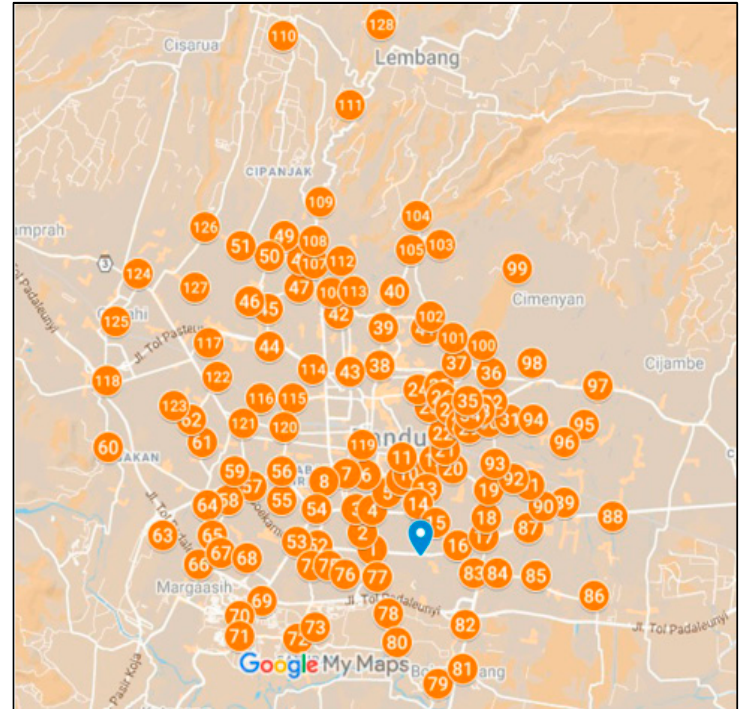
Figure 1. Maps of Bandung city as an item delivery network.